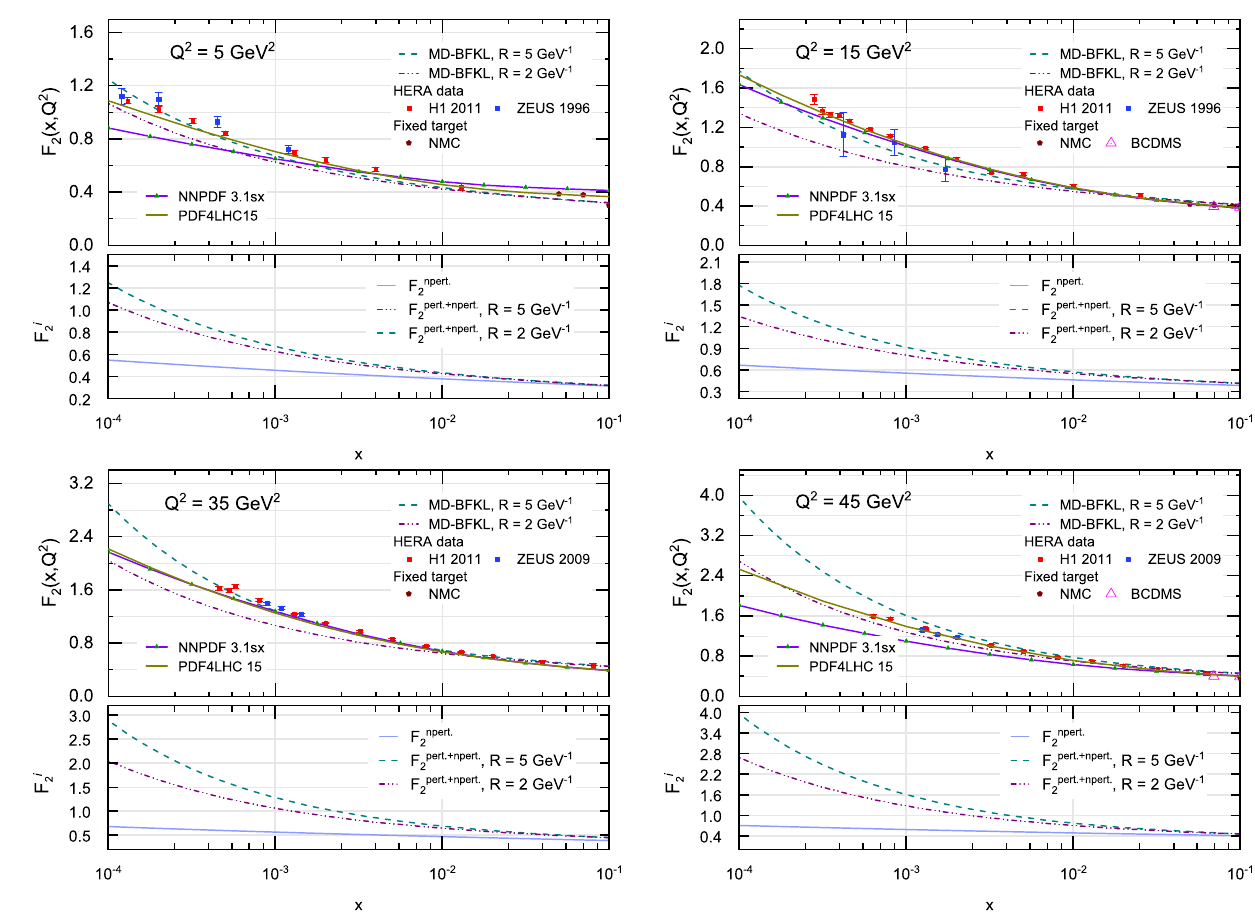
Fig. 14 Prediction for proton structure function F 2 obtained for two choices of shadowing: conventional ( R = 5 GeV − 1 ) and “hotspot” ( R = 2 GeV − 1 ). Data are taken from HERA (H1 [50] and ZEUS [51]) as well as fixed target experiment (NMC [52] and BCDMS [53]). Data-sets from global parametrization groups NNPDF3.1sx [37] and